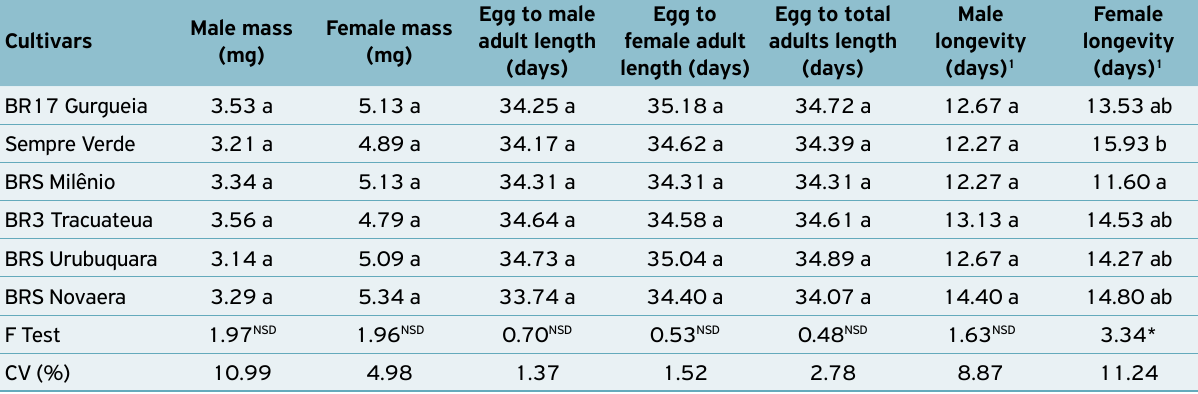
Average values followed by the same letter in column do not statistically differ by the Tukey test at 5% of probability. 1 Data were transformed to (x + 0,5) 1/2 before analysis; 2 data were transformed to arcsen (x/100) 1/2 before analysis; NSD : no statistical difference; *significative at 5%; CV (%):coefficient of variation. Table 3. Average mass, egg‑adult period and male and female longevity of Bruchidius atrolineatus created in cowpea